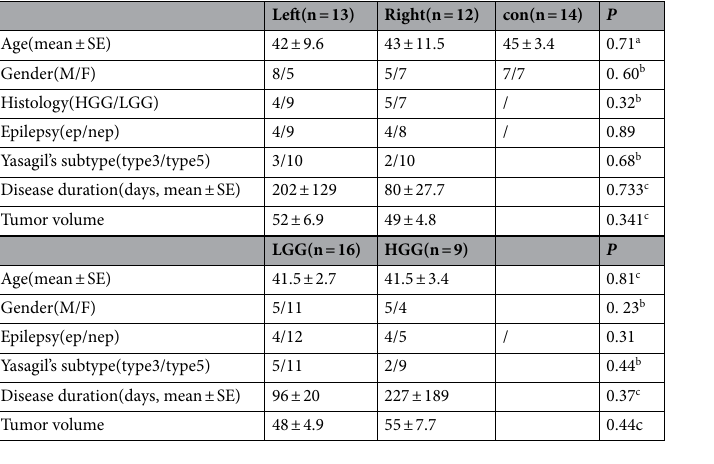
Table 1. Inter-group comparison of Clinical characters of patients. HG glioblastoma and anaplastic glioma(WHO III-IV), LGG low grade glioma(WHO I-II). a One-way ANOVA. b Fisher’s exact test. c Unpaired